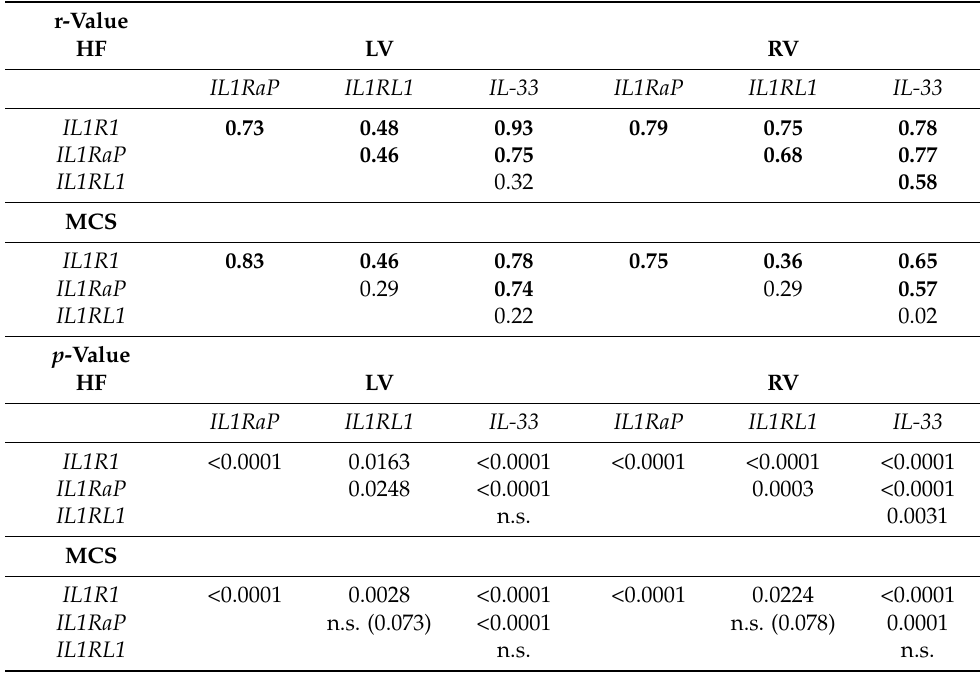
Table 2. Strong correlation between IL-1R1 , IL-1RaP and IL-33